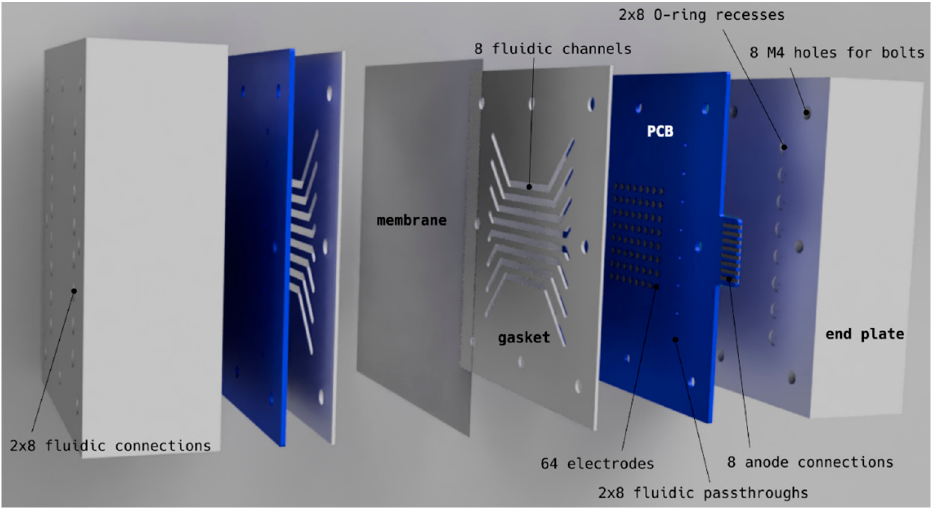
Figure 10. 3D rendering of the HT setup. From left to right: end plate, PCB, gasket, membrane, gasket, PCB, end plate. Fluid enters the setup from the left (catholyte) or right (anolyte), flows through the end plate, through the PCB into the flow channel in the gasket, and back out on the other side of the gasket, and through the PCB and end plate again.